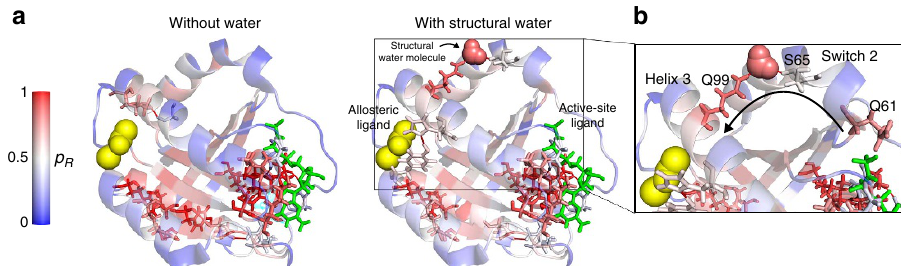
Figure 5 | Structural water molecules are essential for the allosteric pathway in hRas. ( a ) Top percentile bonds by propensity quantile score ( p b Z 0.99) are shown on the structure: the left panel shows pathways identified without the inclusion of water molecules; and the right panel when structural water molecules are included in the graph. The structural water allows the formation of a pathway between the bottom of the switch 2 region and the top of helix 3, where the allosteric binding site is situated. The crucial water molecule which connects Q99 and S65 is indicated. ( b ) Blow-up indicating details of the pathway formed by Q99, a water molecule and S65, linking the allosteric pocket to the switch 2 region. The catalytic residue Q61 is shown at the bottom of switch